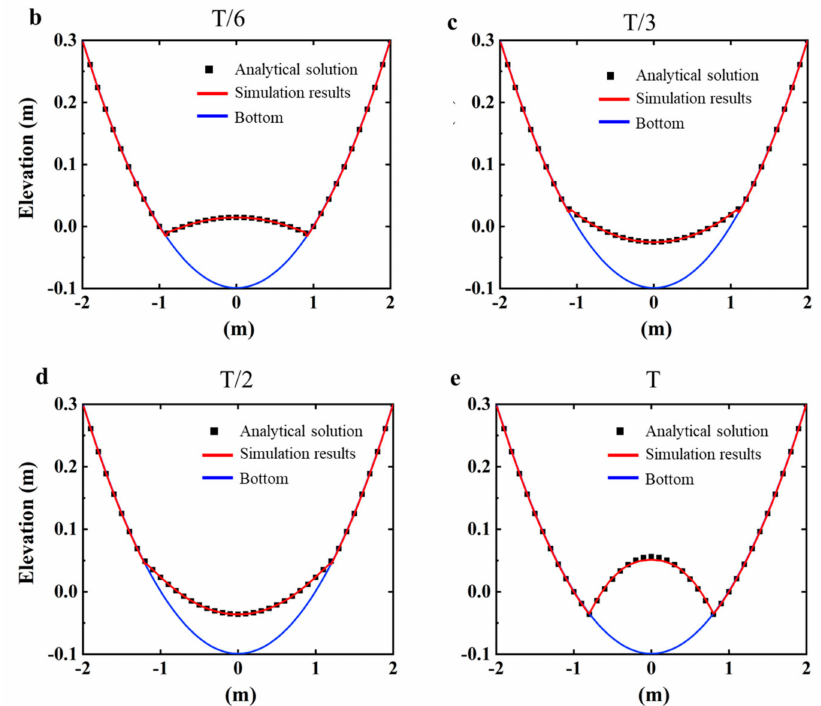
Figure 7. Simulated results compared with real analytical results. ( a ) Geometry of the calculation area and the initial condition; ( b – e ) comparison between the simulated results and the analytical solution at T/6, T/3, T/2, T.